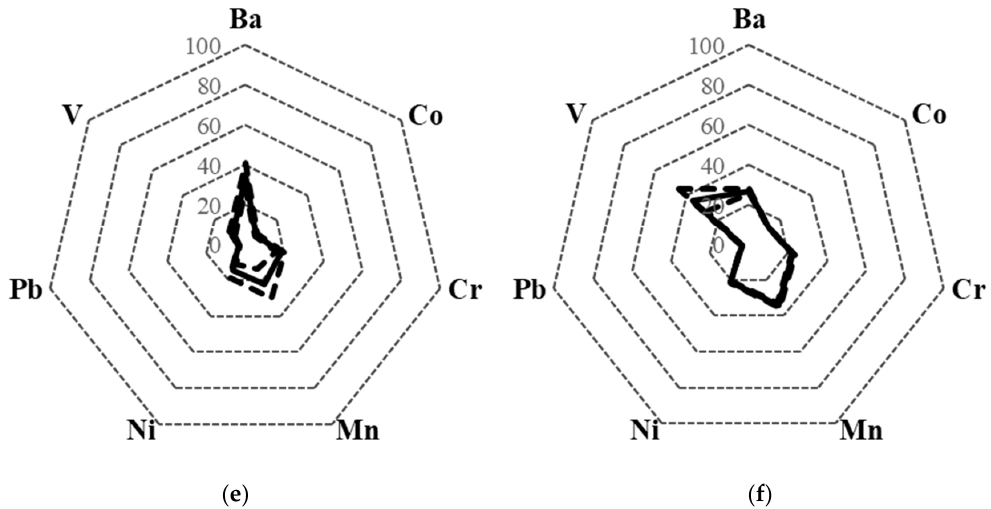
Figure 4. Alternative metal (Ba, Co, Cr, Mn, Ni, Pb and V) fingerprint obtained for ( a ) Alicante; ( b ) Castilla la Mancha; ( c ) Valdepeñas; ( d ) Jumilla; ( e ) Utiel-Requena; ( f ) Campo de Borja. Continuous line: average; broken line: average ± standard deviation. Concentration units: µg kg − 1 . Ba concentration divided by 2 and Mn concentration divided by 25.